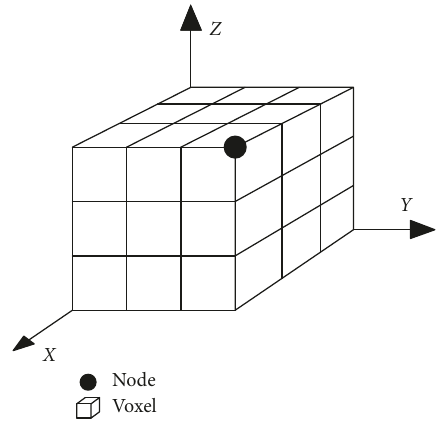
Figure 2: Definition of voxel.